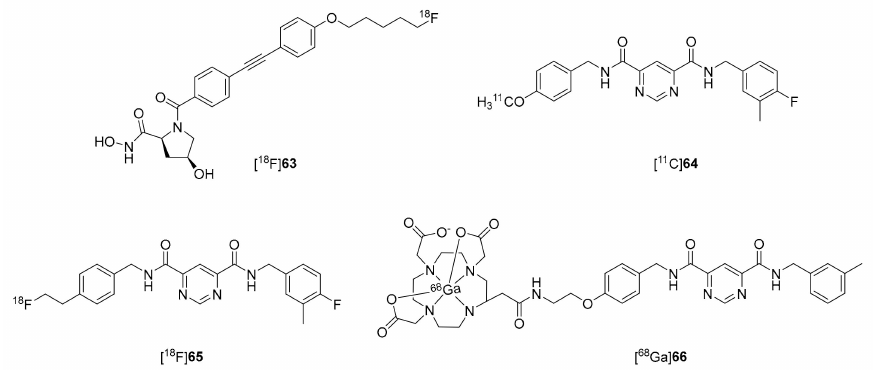
Scheme 15. Chemical structure for compounds 63 – 66 .